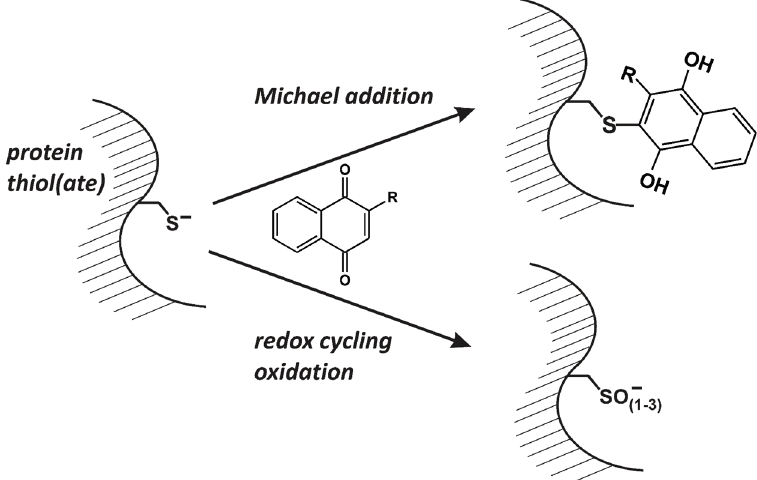
Figure 4. Potential mechanisms for naphthoquinones to cause covalent modification of target proteins. The cysteine thiolate shown can be oxidized by ROS generated through redox cycling to form the corresponding cysteine sulfenate, sulfinate, or sulfonate, and ultimately also a